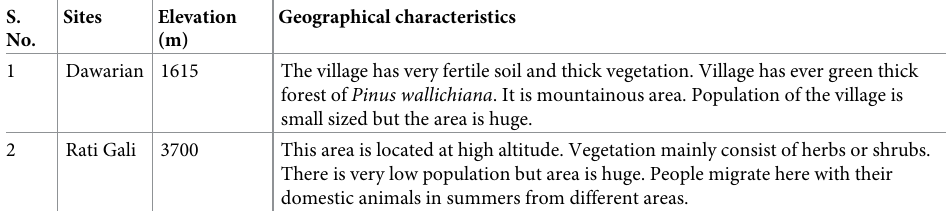
Table 2. Geographical characteristics observation of the two study sites: Rati Galli and Dawarian of District Nee- lam of Azad Jammu and Kashmir. S.